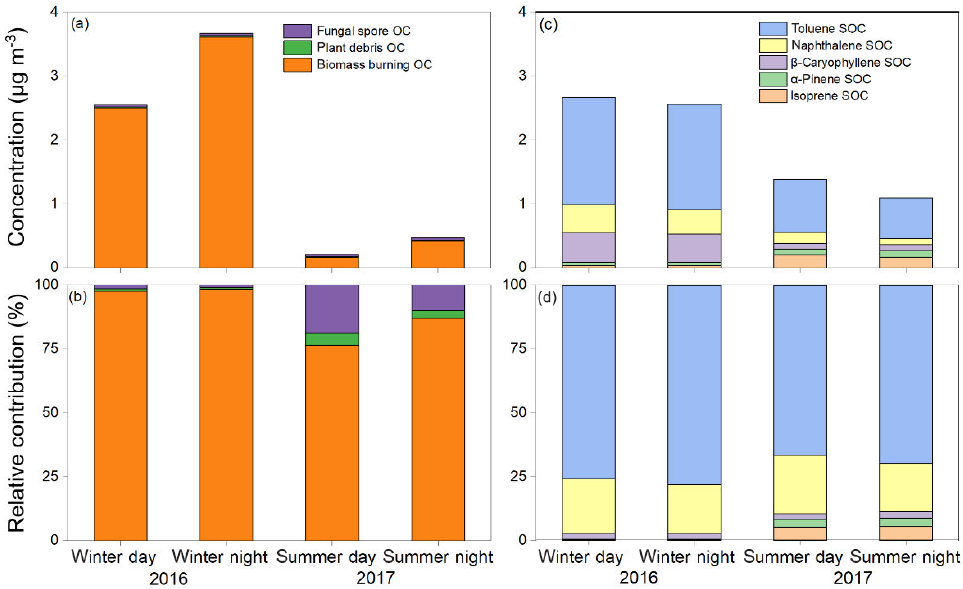
Figure 13. (a) Average concentrations of fungal-spore-derived OC, plant-debris-derived OC, and BB-derived OC in PM 2 . 5 from Tian- jin. (b) Relative contributions of primary OC detected in this study. (c) Average concentrations of toluene SOC, naphthalene SOC, β - caryophyllene SOC, α -pinene SOC, and isoprene SOC in PM 2 . 5 from Tianjin. (d) Relative contributions of SOC identified in this study.